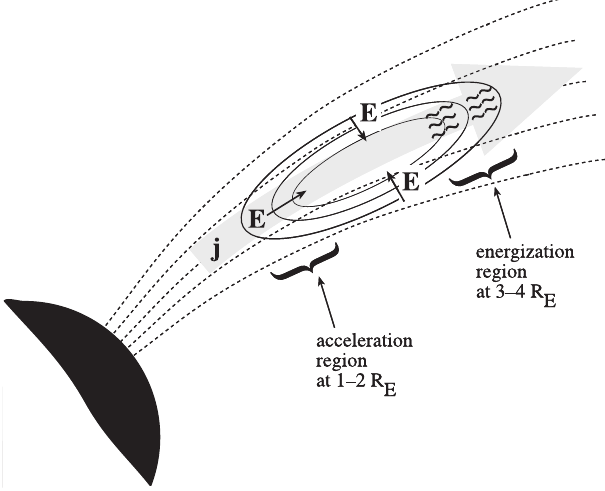
Fig. 19. ‘‘Cooperative’’ model for auroral arc acceleration: the energy is provided by plasma waves in the ‘‘energization region’’, but the agent for acceleration is a static electric field in the acceleration region. The O-shaped potential structure is maintained by the anisotropic pitch angle distribution caused by the waves. Upward electric current carried by the precipitating electrons is indicated by gray